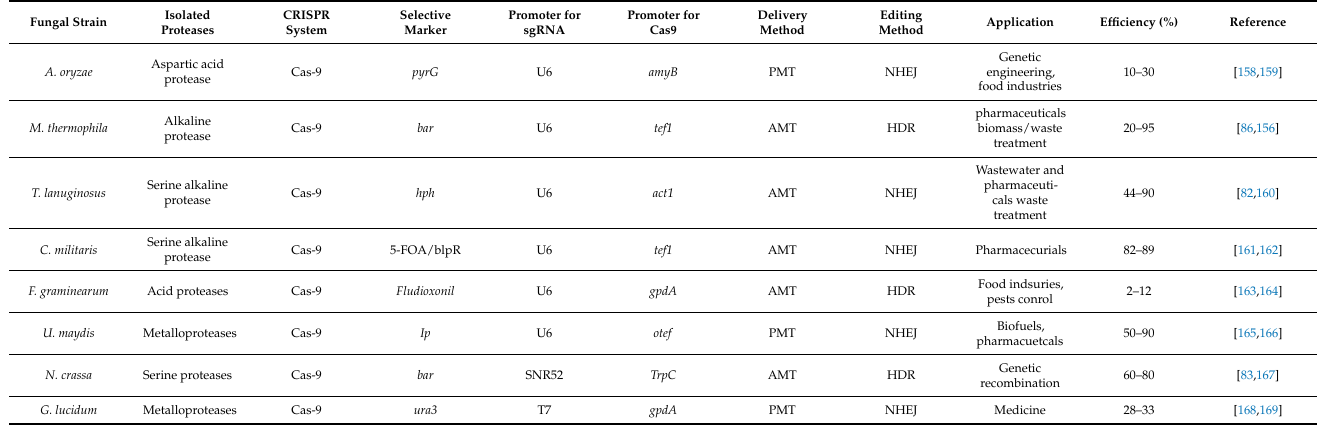
Table 4. The applications and efficiencies of different fungal enzymes isolated from fungal strains recently modified through CRISPR